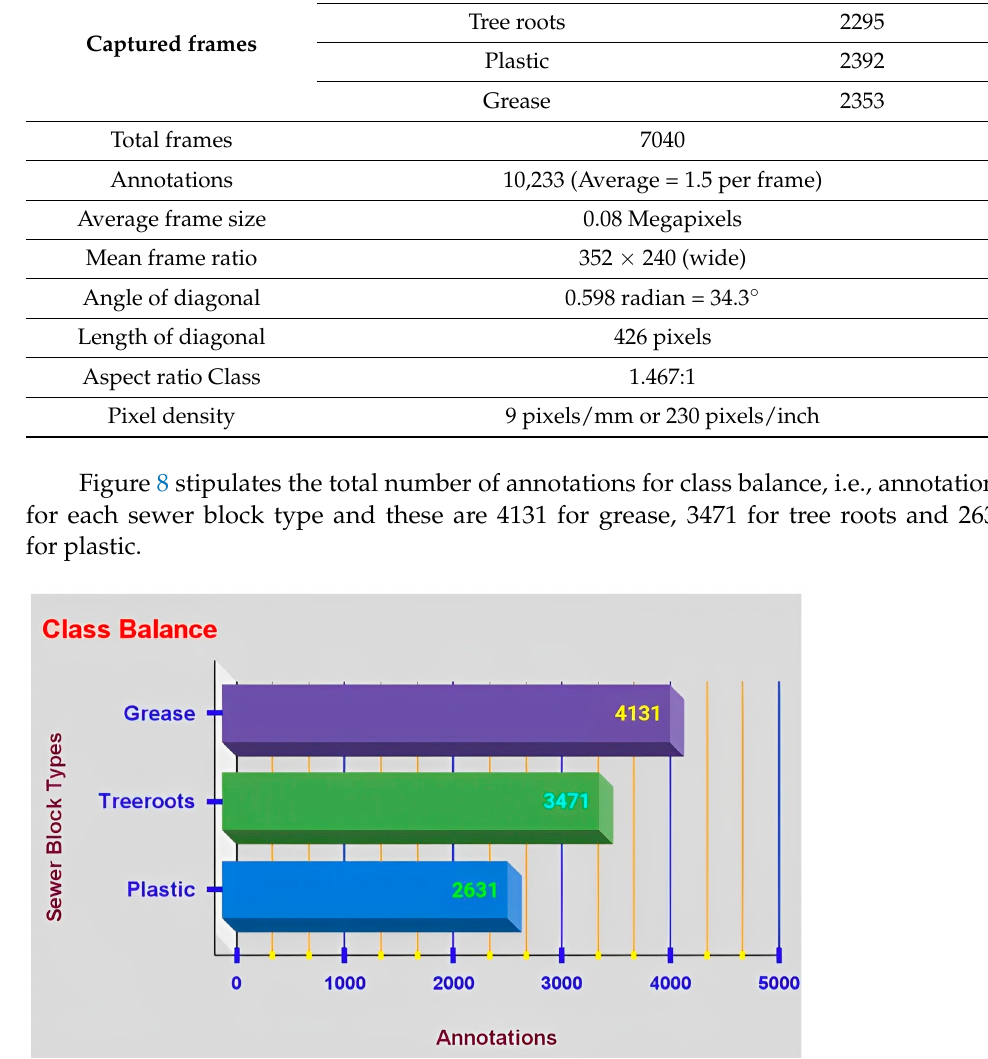
Figure 9. Annotation heatmap details for captured frames. The imagery data is balanced into three groups such as training data with 4928 frames (70%), validation data with 1408 frames (20%) and testing data with 704 frames (10%) as shown in Figure 10.